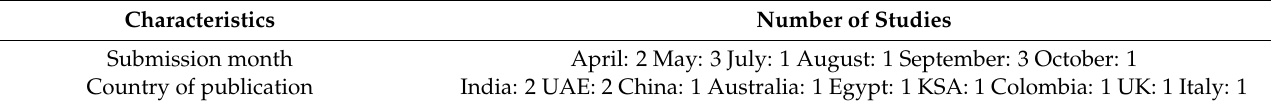
Table 1. Characteristics of the included